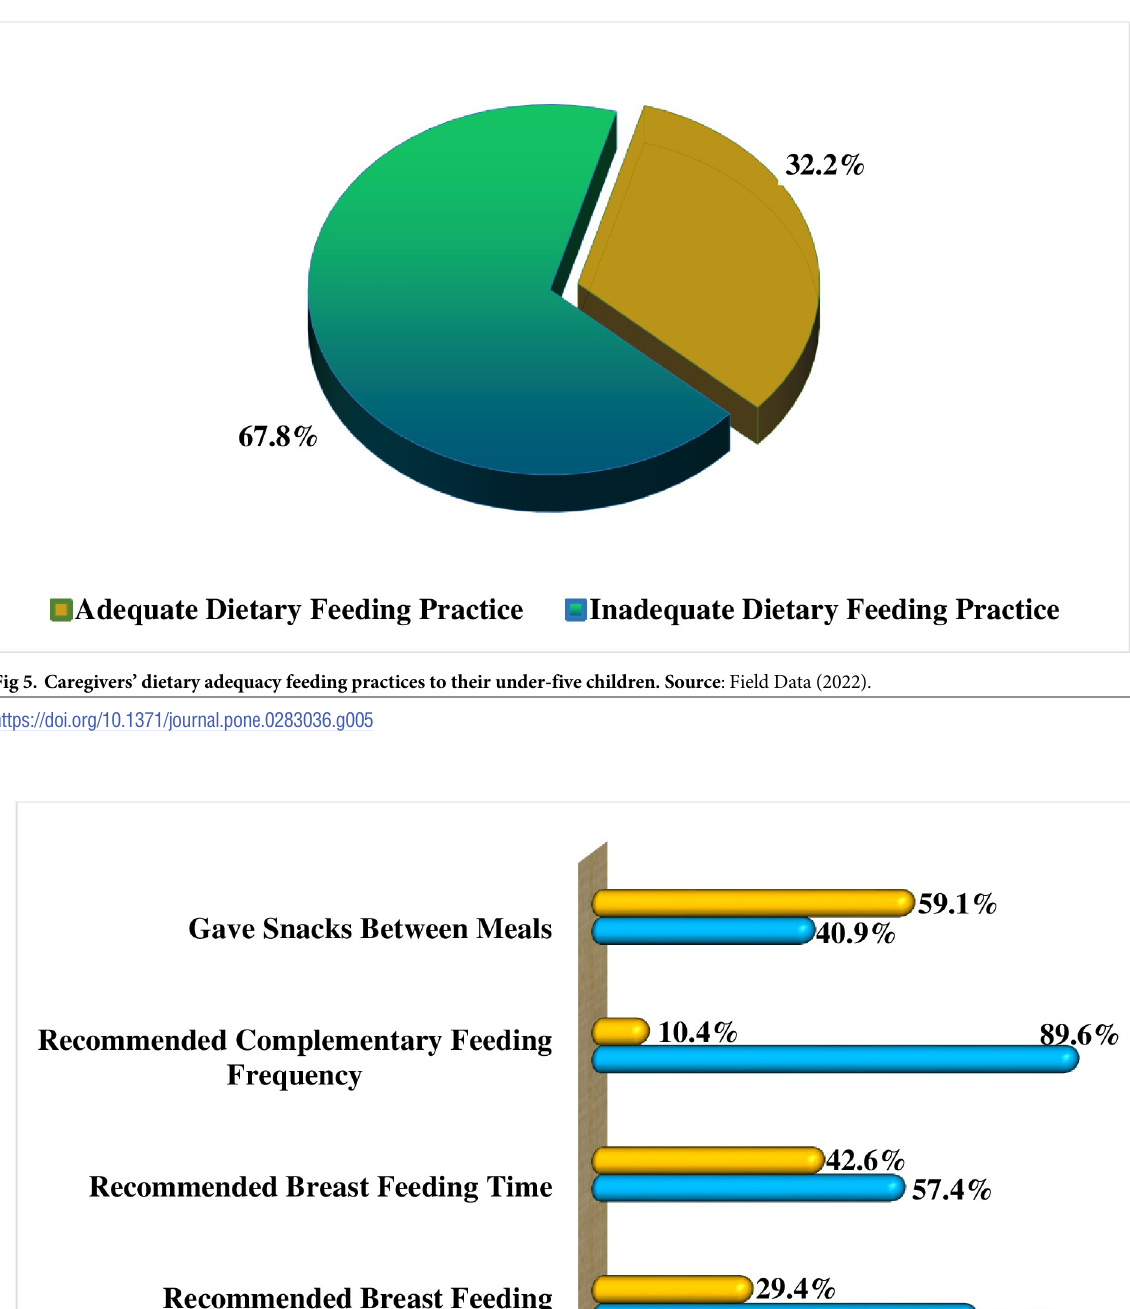
PLOS ONE | https://doi.org/10.1371/journal.pone.0283036 March 22, 2023 12 /